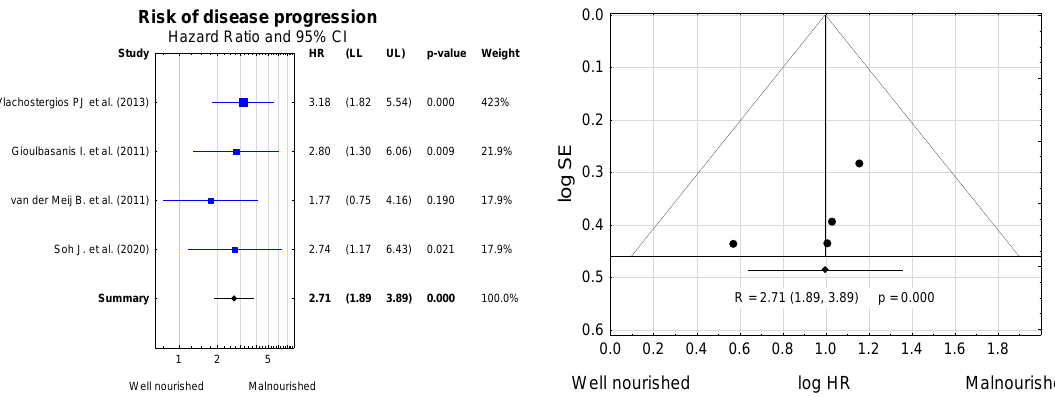
Figure 7. Risk of disease progression in lung cancer patients differing by nutritional status (expressed by hazard ratio (HR)), and funnel plot for visual assessment of the probability of systematic bias due to selective publication of studies. LL — lower limit of the confidence interval; UL — upper limit of the confidence interval for the effect measure ( HR ).